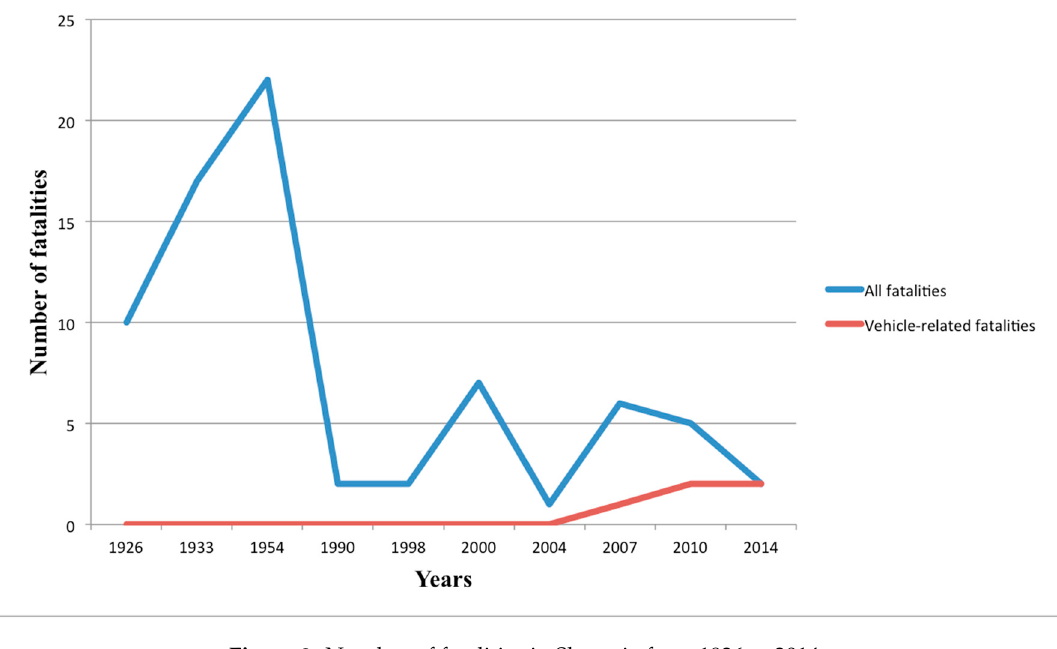
Water 2020 , 12 , x FOR PEER REVIEW Figure 2. Number of fatalities in Slovenia from 1926 to 2014. Figure 2. Number of fatalities in Slovenia from 1926 to 2014.